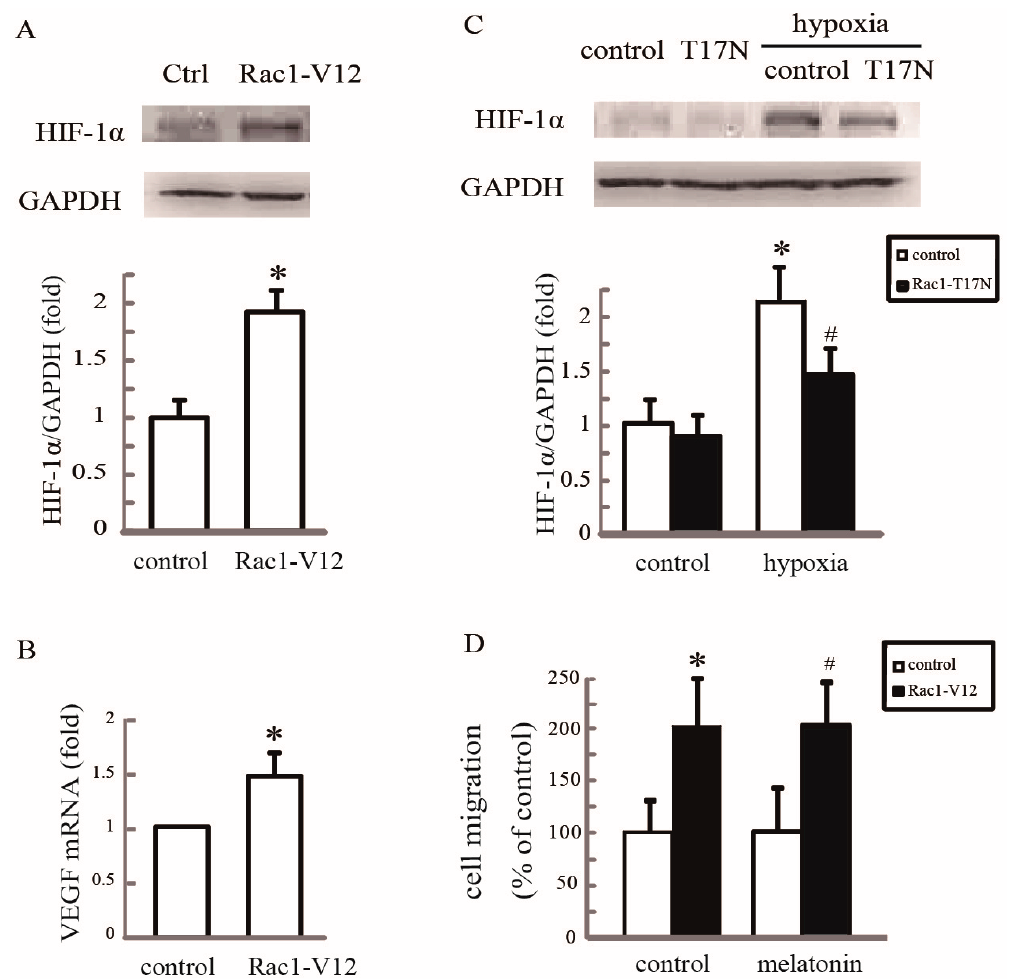
Figure 5. Rac1 is required for melatonin-reduced HIF-1 α expression in hypoxic HUVECs. ( A ) Overexpression of Rac1-V12 promoted HIF-1 α expression. Cells were transfected with empty vector or Rac1-V12, and western blotting was performed to examine HIF-1 α expression; ( B ) A q-PCR assay was performed to examine VEGF mRNA. * p < 0.05, referring to the difference between cells transfected with Rac1-V12 and empty vector; ( C ) Overexpression of Rac1-T17N inhibited hypoxia-mediated HIF-1 α expression. Cells transfected with an empty vector or Rac1-T17N were grown under hypoxia for 2 h, and HIF-1 α expression was examined by western blotting. * p < 0.05, referring to the difference between cells treated with and without hypoxia; # p < 0.05, referring to the difference between hypoxic cells transfected with Rac1-T17N and empty vector; and ( D ) Melatonin failed to affect migration of cells overexpressing Rac1-V12. Cells transfected with an empty vector or Rac1-V12 were treated with 100 µM melatonin, and the cell migration rate was determined by wound closure assay. * p < 0.05, referring to the difference between cells transfected with Rac1-V12 and empty vector; # p < 0.05, referring to the difference between cells transfected with Rac1-V12 plus melatonin relative to the cultures with empty vector plus